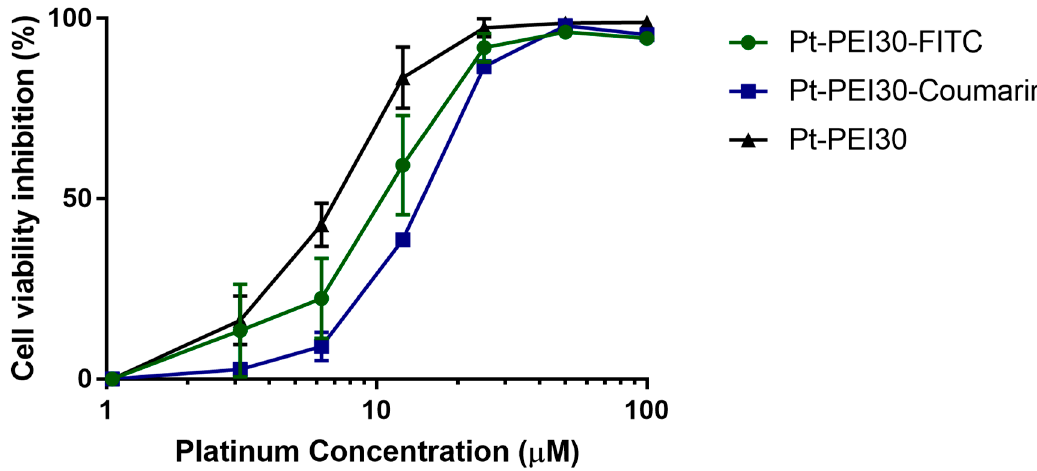
Figure 7. Effects on HCT116 cell metabolic activity of fluorescent Pt-PEI30 conjugates and non-fluorescent Pt-PEI30 compound as a reference. Results are expressed as mean ± SEM of at least two independent experiments. All concentrations (in µM) are expressed as platinum concentration.